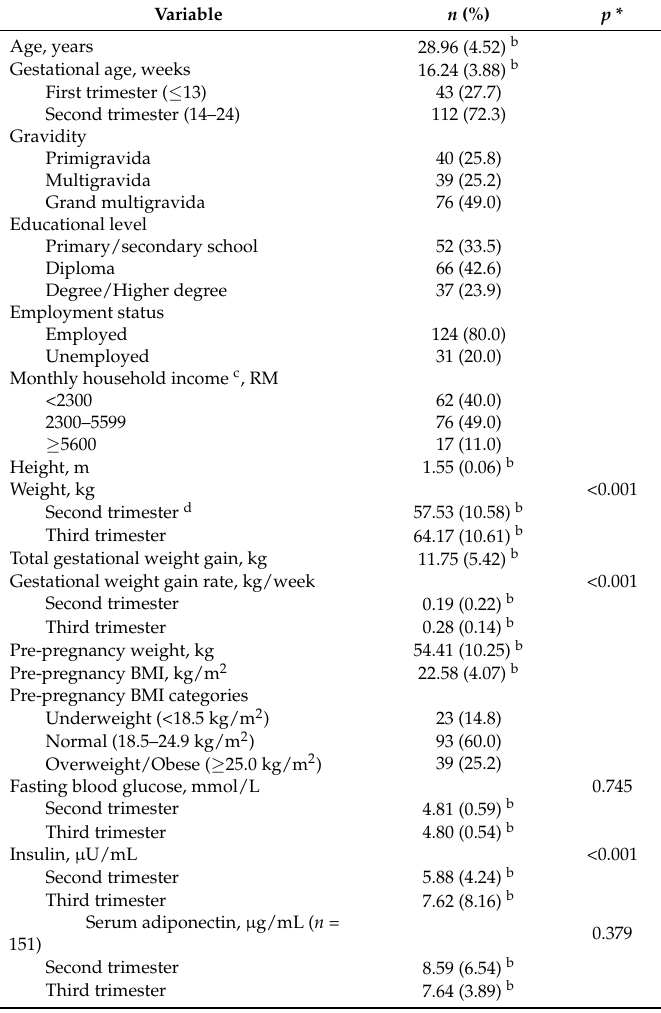
Table 1. Maternal characteristics a